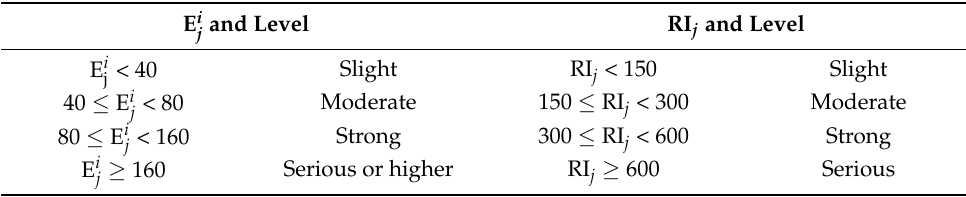
, RI j , and their ecological risk levels. j